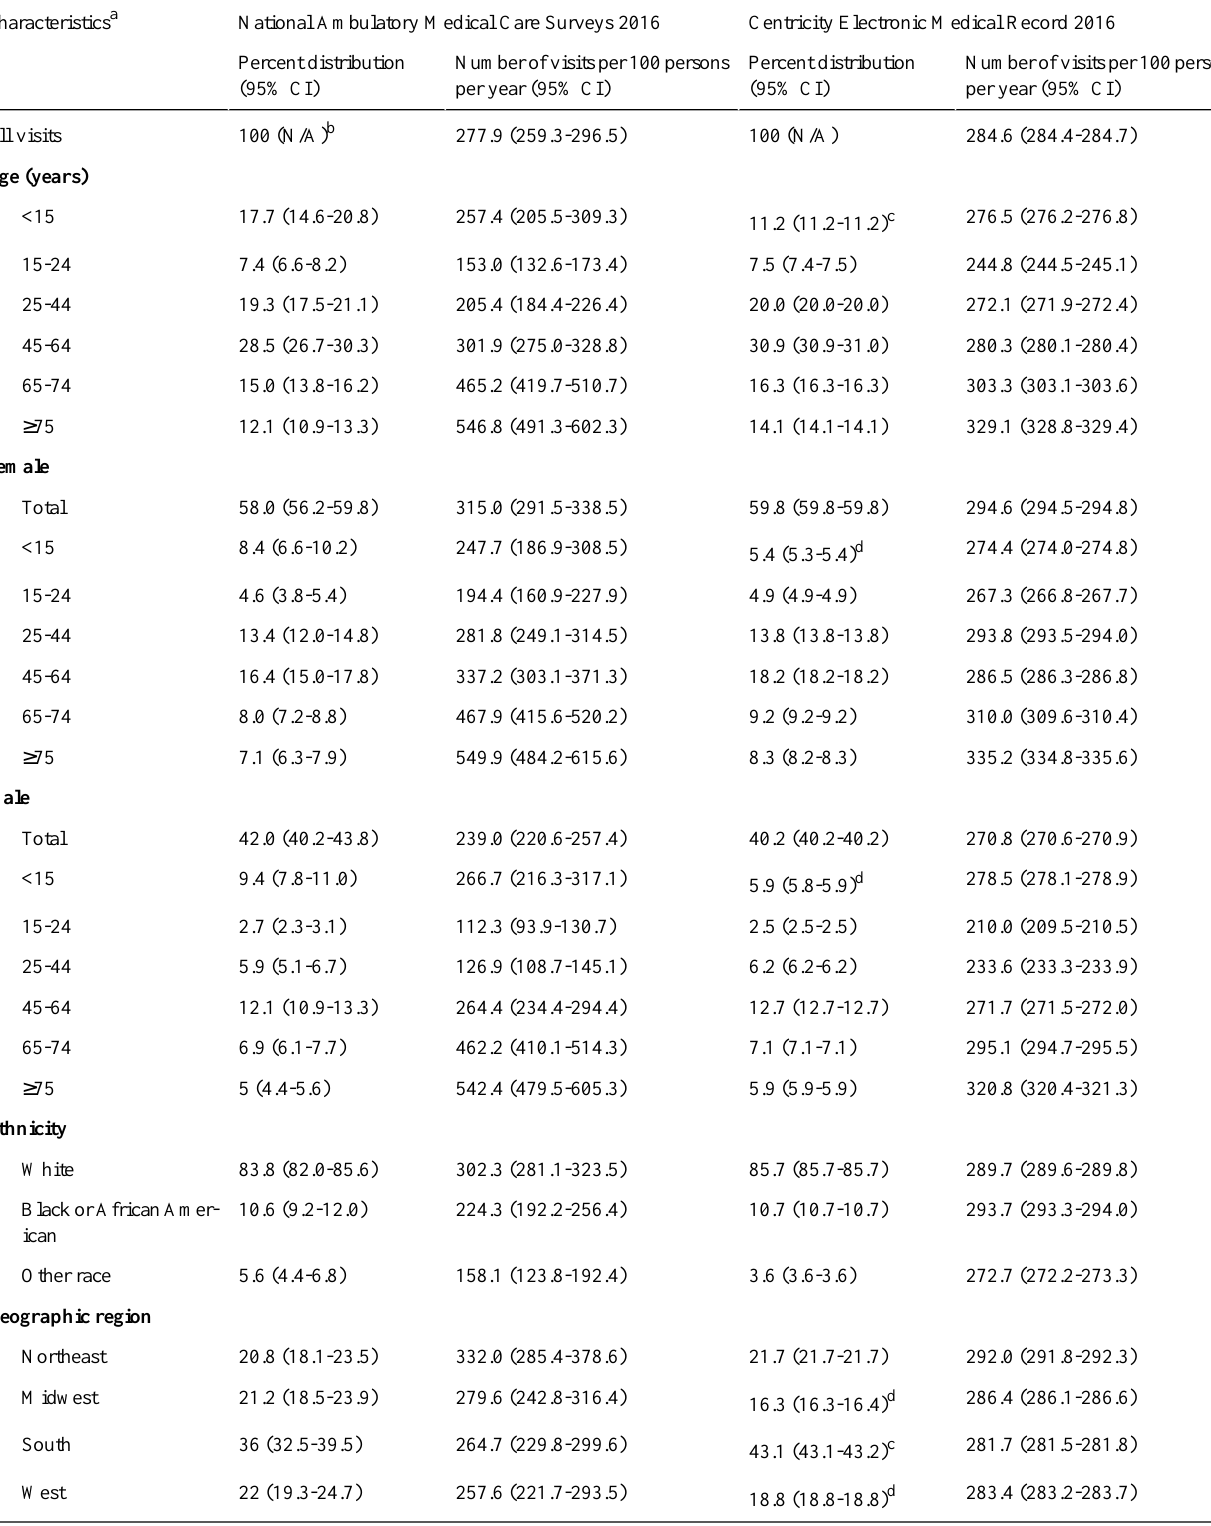
a Pairwise comparisons for the equivalence of percent distributions between National Ambulatory Medical Care Surveys and Centricity Electronic Medical Record were conducted using the two one-sided test. The unmarked categories were all equivalent at a 2.5 percentage point margin. b N/A: not applicable. c Not equivalent at both 2.5 and 5.0 percentage point margins. d Not equivalent at 2.5 percentage point